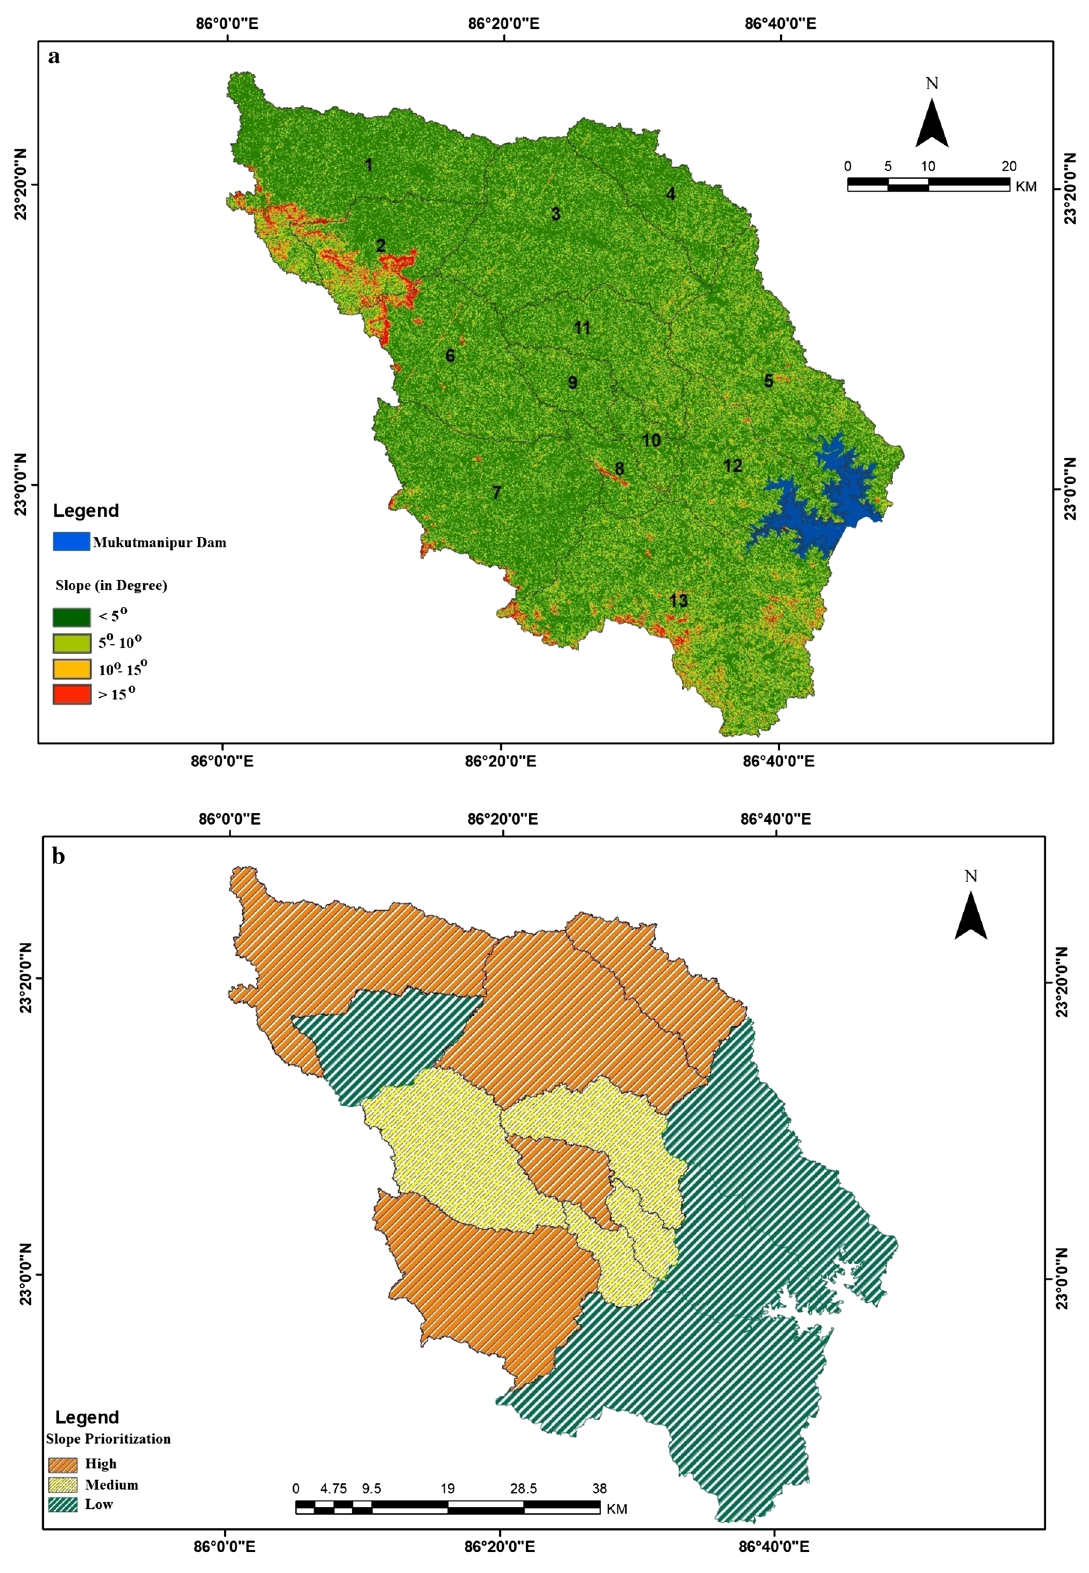
Fig. 7 a Slope analysis in Kansai–Kumari reservoir catchment area and b priority based on slope parameter in Kansai–Kumari reservoir catch- ment